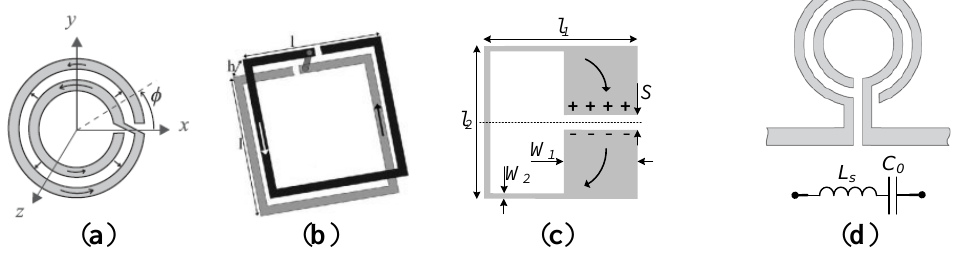
Figure 5. Topology of the ( a ) two-turn spiral resonator (2-SR), ( b ) BC-SR, ( c ) folded stepped impedance resonator (SIR) and ( d ) open split ring resonator (OSRR) (including the circuit